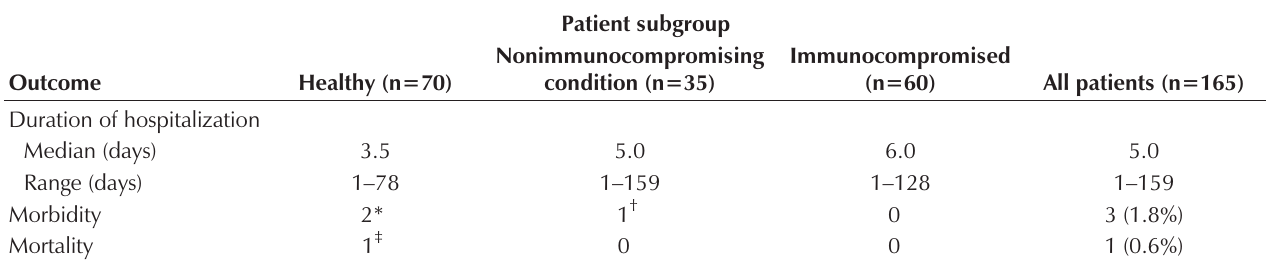
Outcome of patients admitted with varicella zoster virus (VZV)